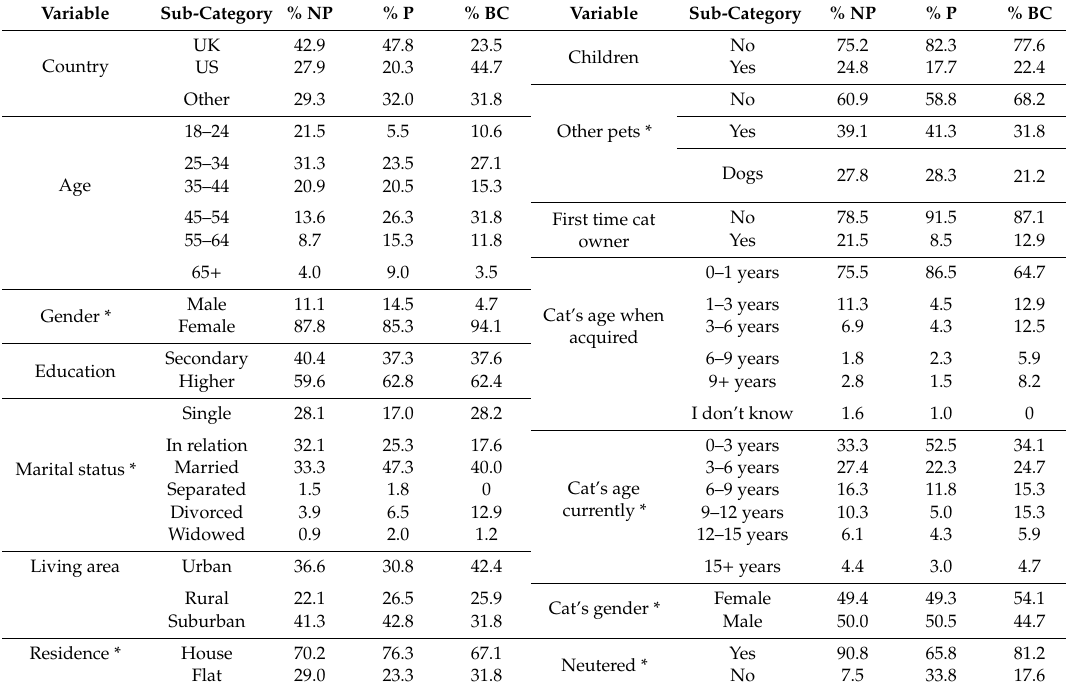
Table 3. Characterisation of owners by cat